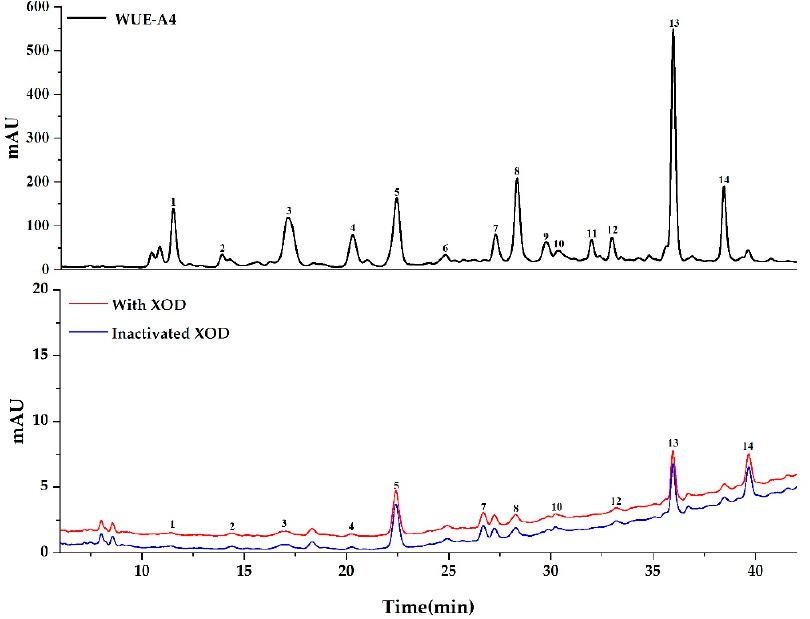
Figure 4. The UF-HPLC-UV chromatograms of WUE-A4 with xanthine oxidase. The black, red, and blue lines represent the HPLC-UV profiles of WUE-A4 without ultrafiltration, with activated xanthine oxidase, and with inactivated xanthine oxidase, respectively.